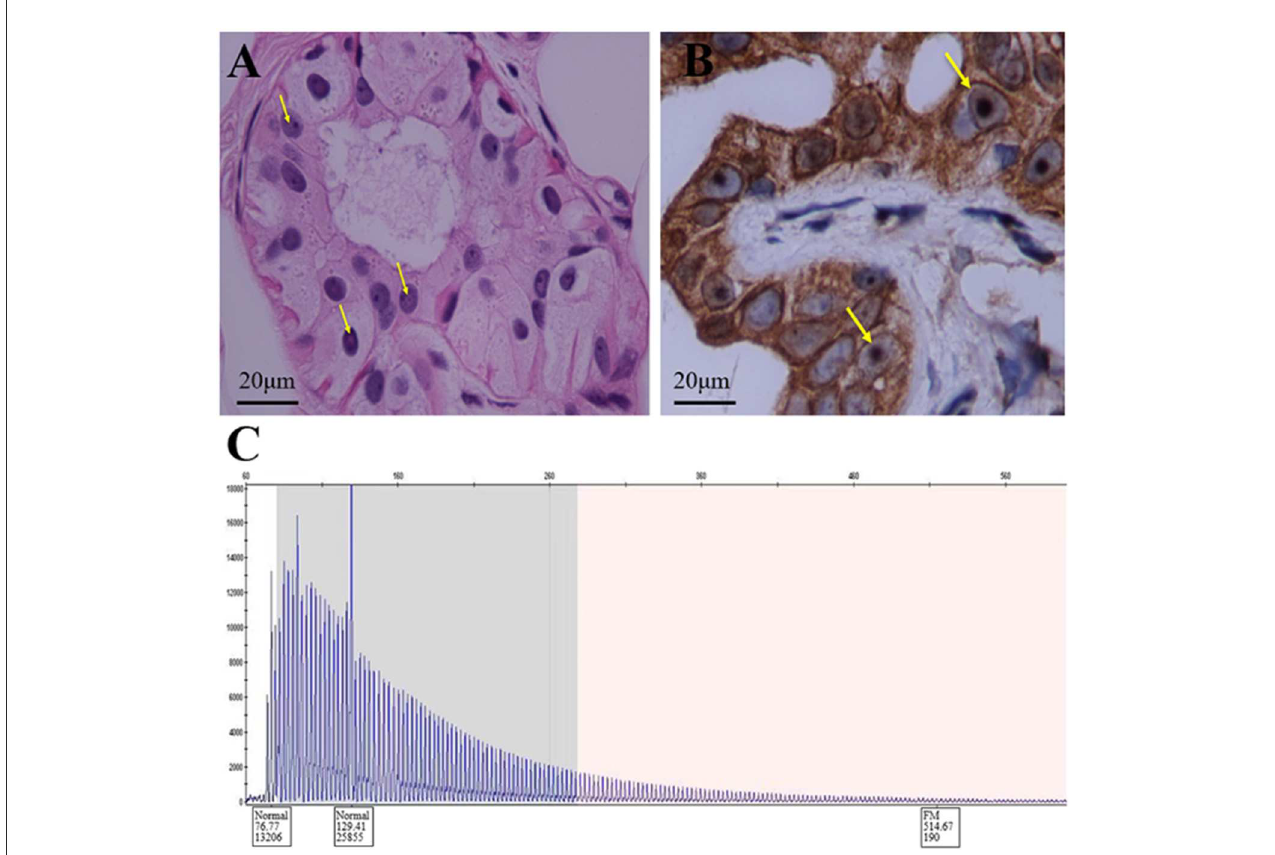
FIGURE2 Histopathologic and genetic analyses of the patient. (A) Hematoxylin-eosin staining shows eosinophilic inclusion bodies in some sweat gland cells. Scale bars 20 µ m. (B) Anti-P62 immunohistochemical staining. Visible inclusion bodies in the nucleus of some skin sweat gland cells. Scale bars 20 µ m. (C) RP-PCR of the patient with a characteristic saw-tooth pattern for an expansion of 151 GGC repeated in the 5 ′ -untranslated region of the NOTCH2NLC gene. RP-PCR, repeat-primed